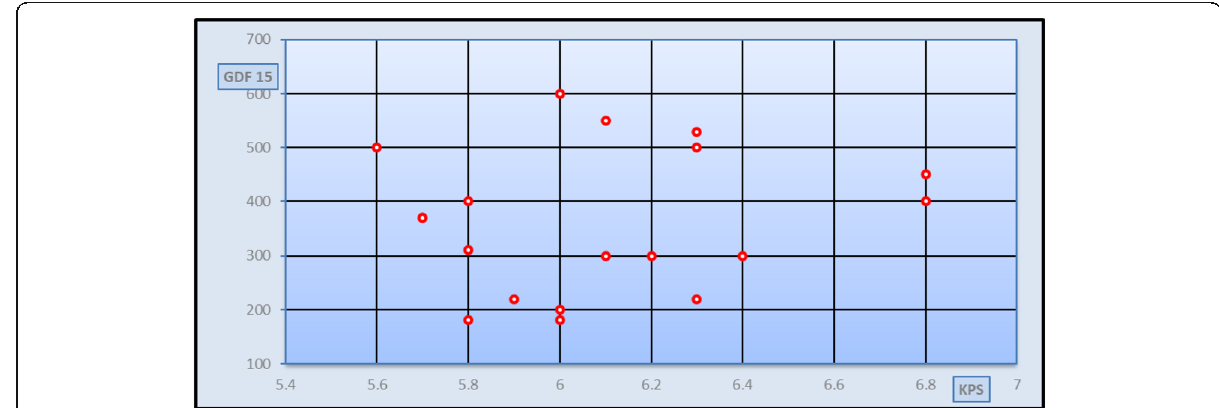
Fig. 2 Correlation study between GDF-15 and fibroscan in KPS in group I patients [ r = 0.15 and p = 0.553